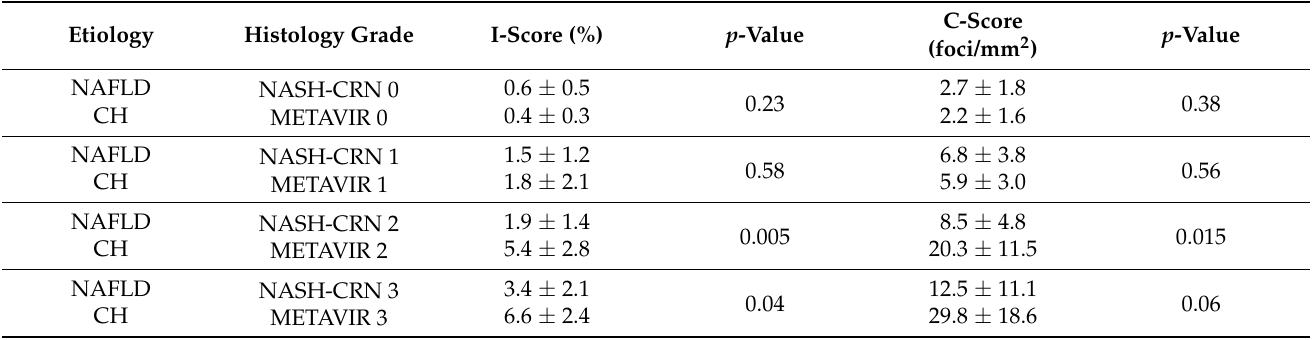
Table 3. Summary of I-score (%CD45+) and C-score (clusters proportion) results (mean ± SD) for each grade of inflammation. The p -value indicates the significance of paired distributions comparison between NAFLD and chronic hepatitis.